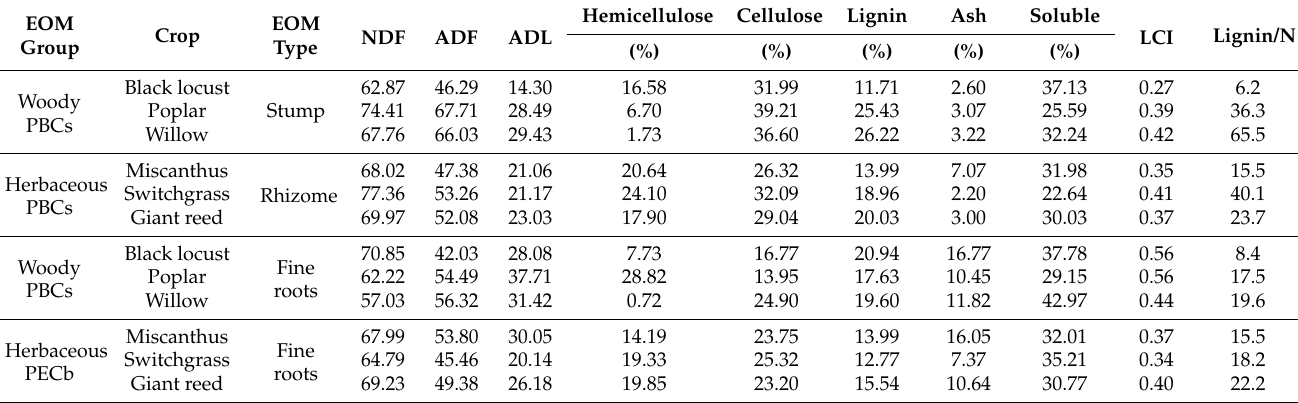
Table 3. Cell wall composition of exogenous organic matter used in the